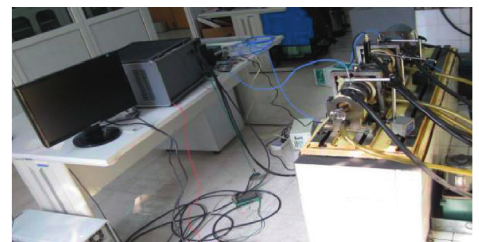
Figure 6: The picture of the test rig.